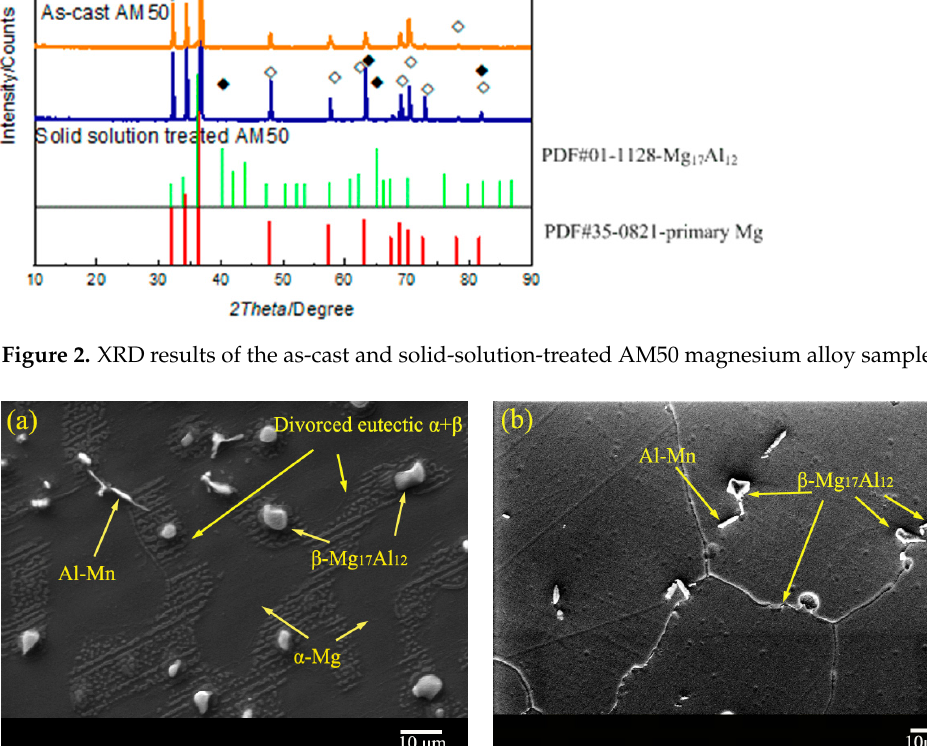
Figure 3. SEM images of the microstructures of the ( a ) as-cast and ( b ) solid-solution-treated AM50 magnesium alloy magnesium alloy samples.